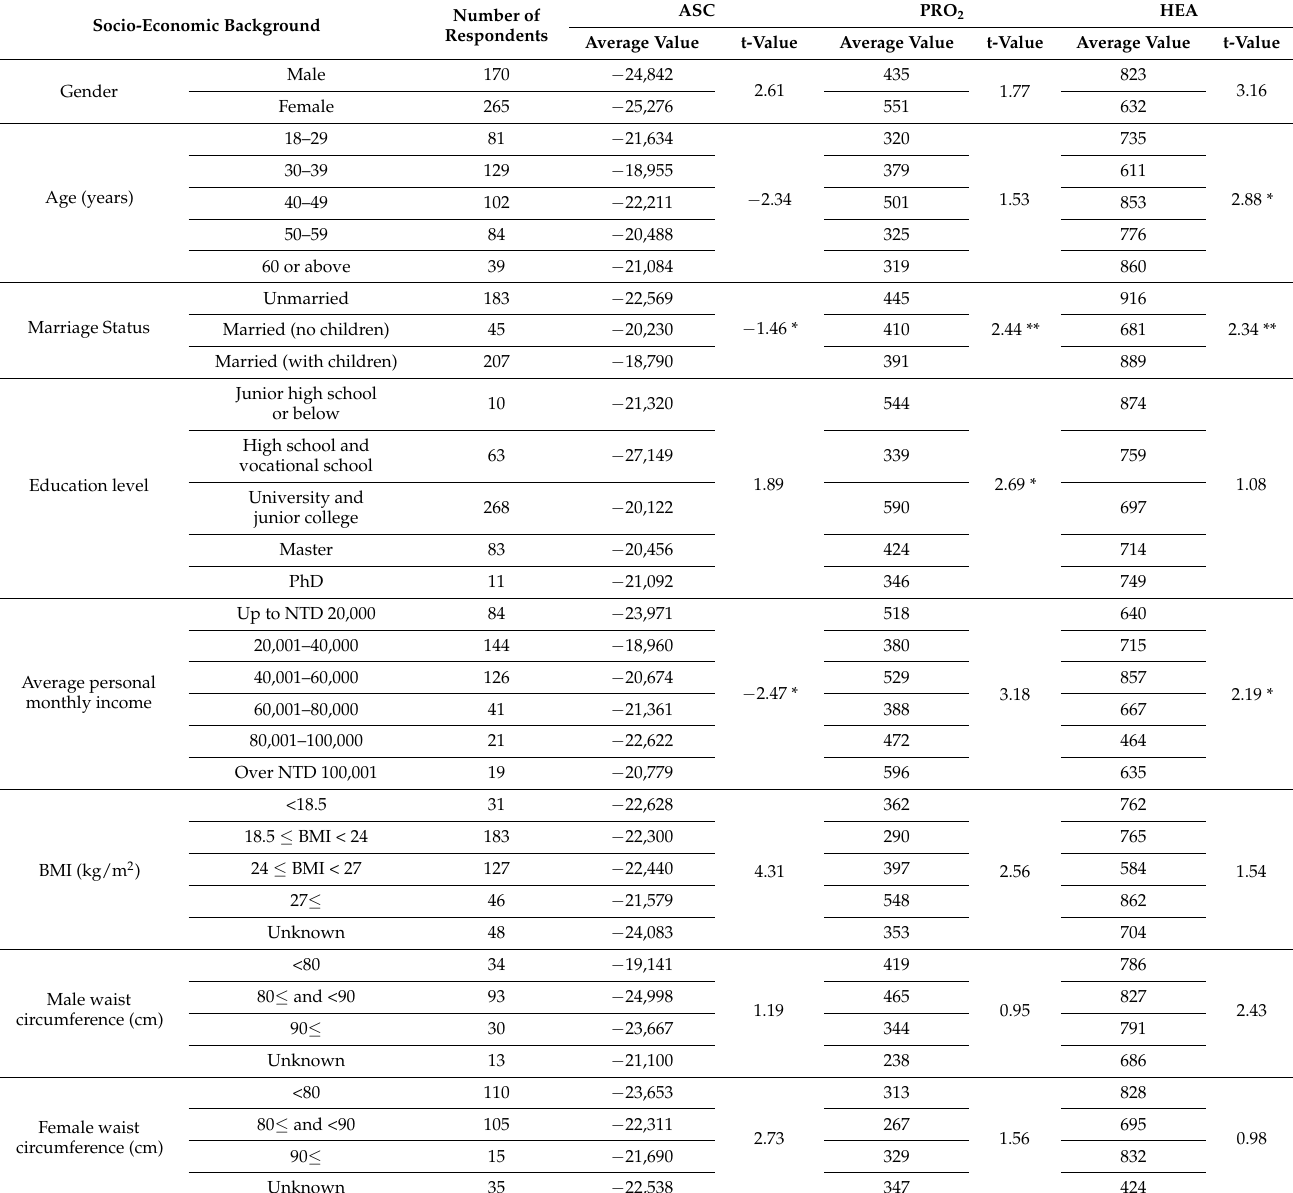
Table 8. Respondents’ socio-economic backgrounds and the WTPs associated with selected yogurt